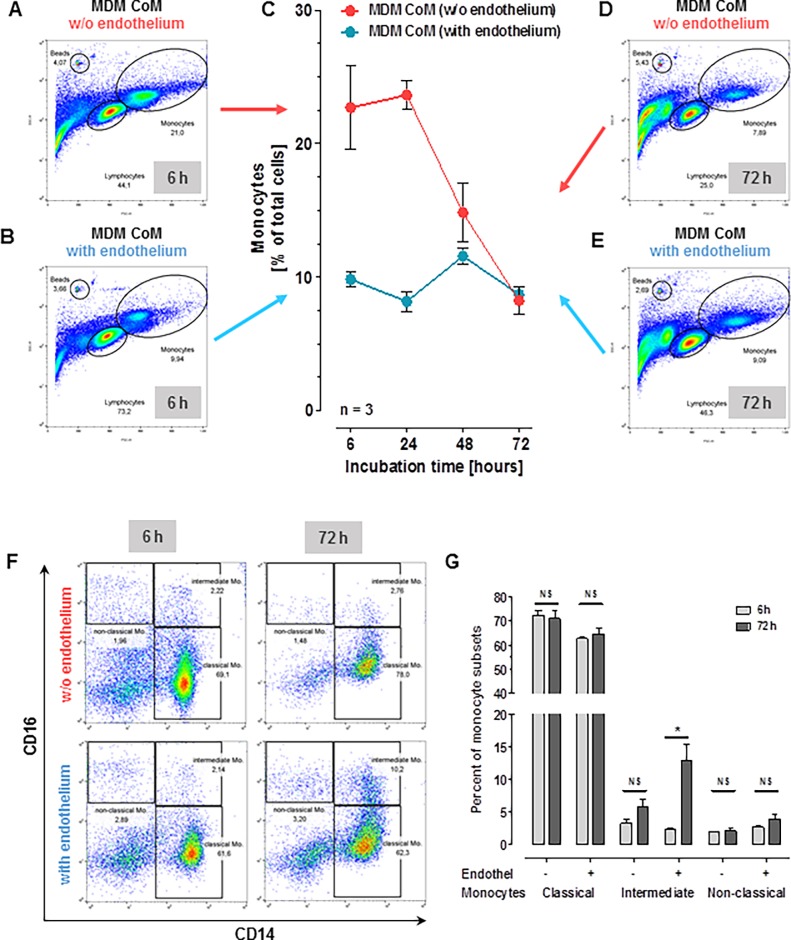
Monocyte fraction persistence.(A—E) For analysis, freshly isolated monocytes were incubated in pooled supernatant from MDM stimulated with corneal tissue; monocytes were identified using flow cytometry (depicted for six (A and B) and 72 hours (D and E) of incubation). The monocyte fraction was determined based on the percentage of gated cells shown in flow cytometry plots. FACS was performed after six, 24, 48 and 72 hours of incubation (Fig 4C). Counting beads were used to ensure consistent cell counts in all samples. The presence (blue) or absence (red) of corneal endothelium (CEC) during the initial MDM stimulation is indicated. In the absence of CEC twice as many monocytes can be found after six hours of incubation. Gated monocytes (as in A, B, D, and E) were further sub-differentiated into classical (CD14++CD16−), intermediate (CD14++CD16+), and non-classical (CD14+CD16++) monocytes (Fig 4F). Monocytes incubated with supernatant from MDM stimulated with endothelium showed a statistically significant increase in intermediate monocytes (Fig 4F and G; * p<0.05).